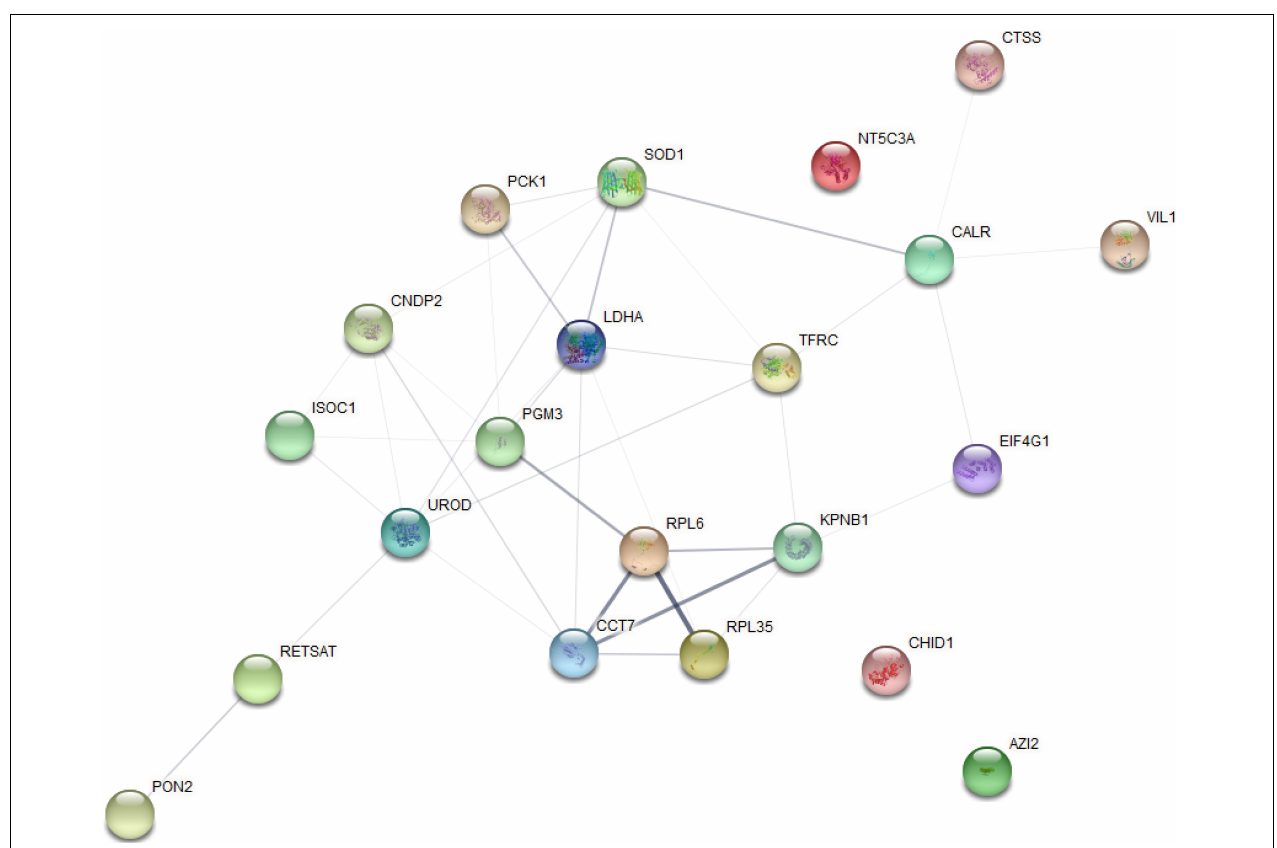
FIGURE 7 | Protein–protein interaction network analysis based on the profile (VII) for STEM